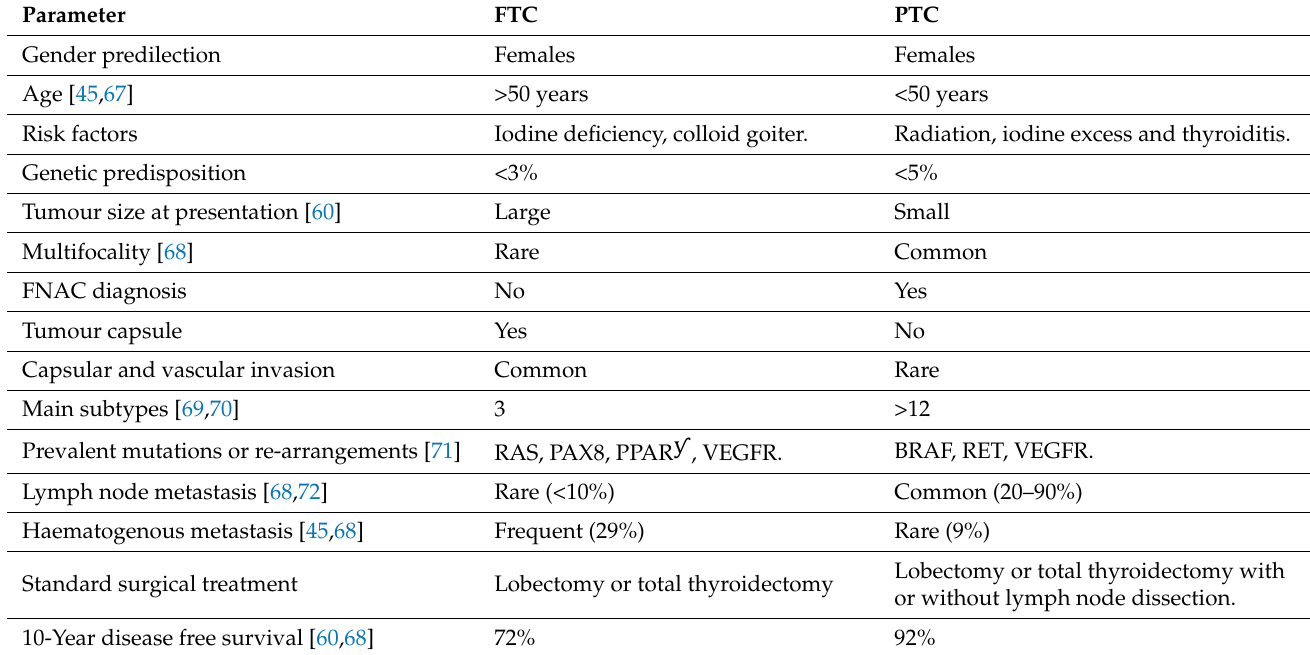
Table 1. Comparison of demography and clinicopathological features of follicular and papillary carcinomas.